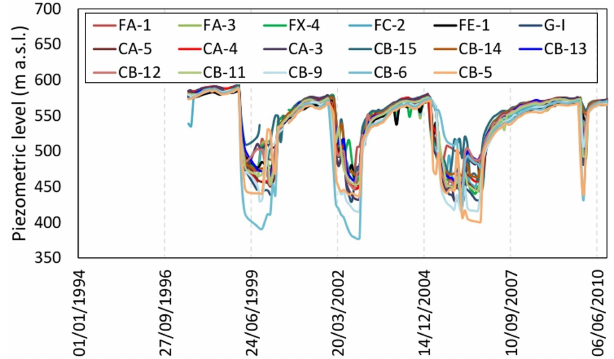
Figure 3. Piezometric head time series acquired in the period 1998– 2010. The location of the observation wells is reported in Fig.